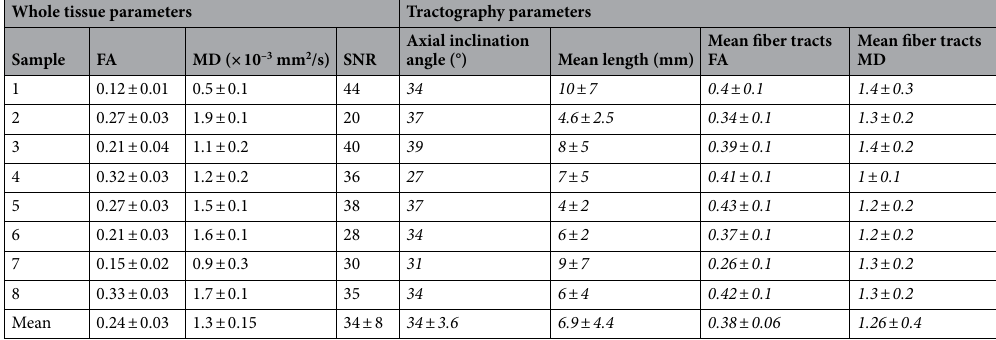
Table 1. Quantitative DTI parameters with standard deviation from whole tissue and from tractography. In italics, mean parameters extracted from tractography of whole samples, with standard deviations shown when